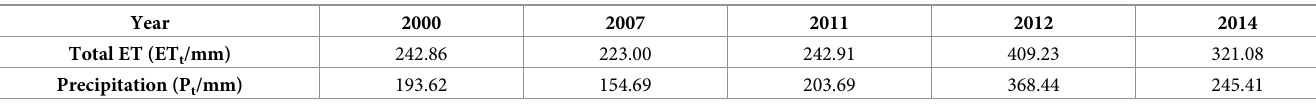
Table 3. Precipitation and total evapotranspiration during the growing